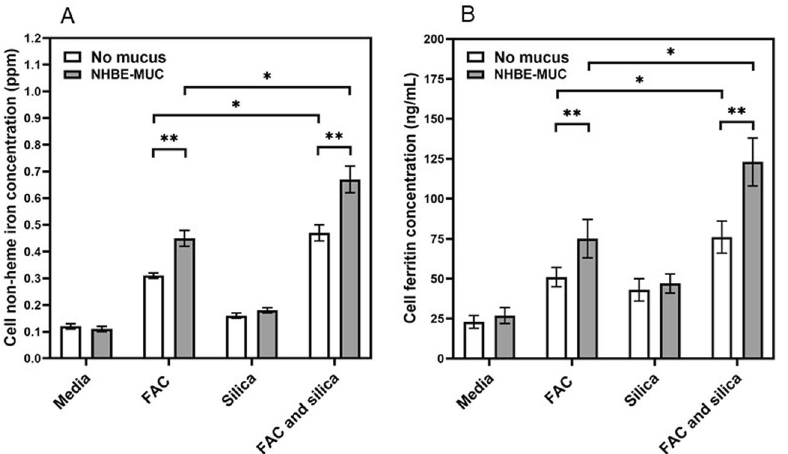
Figure 7. Cell iron and ferritin concentrations after exposures to mucus, iron, and silica. With FAC exposure, BEAS-2B cells imported iron ( A ). Those cells exposed to iron, mucus, and silica had the highest levels of iron. In a comparable manner, those exposures of BEAS-2B cells to iron, mucus, and silica demonstrated the greatest ferritin concentrations ( B ). One way ANOVA was employed. *Increased relative to FAC (p < 0.05); **increased relative to without mucus (p < 0.05).